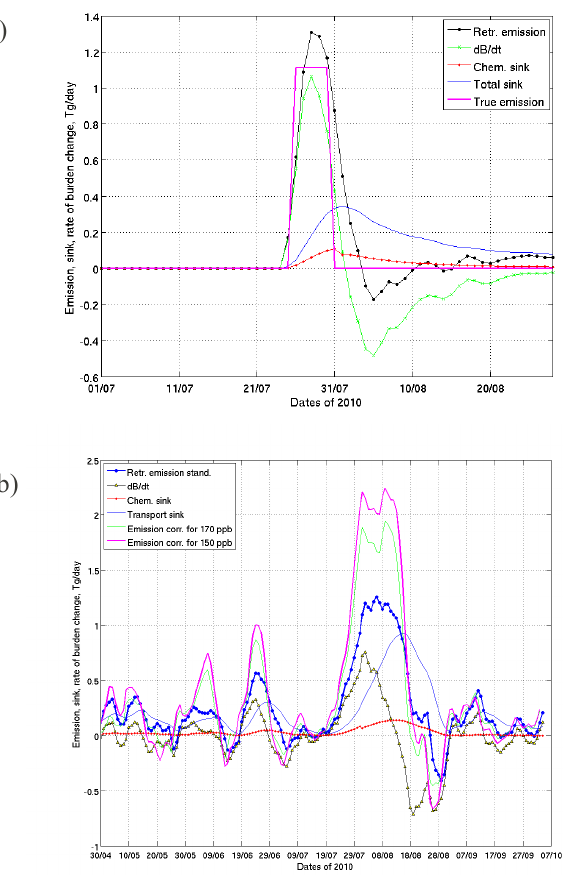
Fig. 14. (a) A test of the mass balance model. Magenta line is the emission of simulated fire (“true emission”) in the central Russia with 1.11Tgday − 1 (5.55Tg of total emission). CO burden calcu- lated by the GEOS-5 see in Fig. 13a. [OH] for the chemical sink is according to Spivakovsky et al. (2000). The transport sink is cal- culated as B /TAU trans (see Fig. 13b for TAU trans ) . The retrieved emission rate is plotted as the blue line and dots. Retrieved total emitted CO for this case is 7.67Tg that is 38% larger than that ini- tially set in the model. (b) The CO fire emission retrieved from MOPITT V4 data for 2010. The blue line with dots is for measured burdens. Measured burdens were added by MCO, and corrected emissions are plotted for two assumptions on the plume boundary: VMR-500 > 150ppb and VMR-500 >